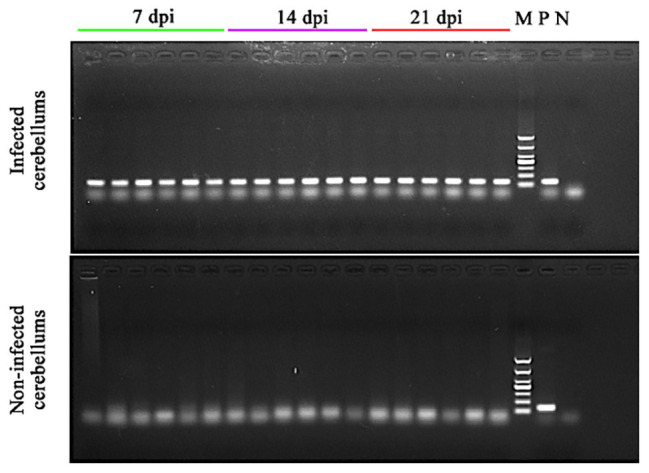
Confirmation of the presence of Toxoplasma gondii infection in the cerebella of the infected mice. DNA was extracted from the cerebellum of infected and non-infected mice at 7, 14, and 21 dpi and used in PCR to detect T. gondii B1 gene. 7 dpi (lanes 1–6), 14 dpi (lanes 7–12), and 21 dpi (lanes 13–18): PCR amplicons from the cerebellum of infected (top image) and non-infected (bottom image) mice; M, DNA marker; P, T. gondii PCR positive control; and N, PCR negative control.